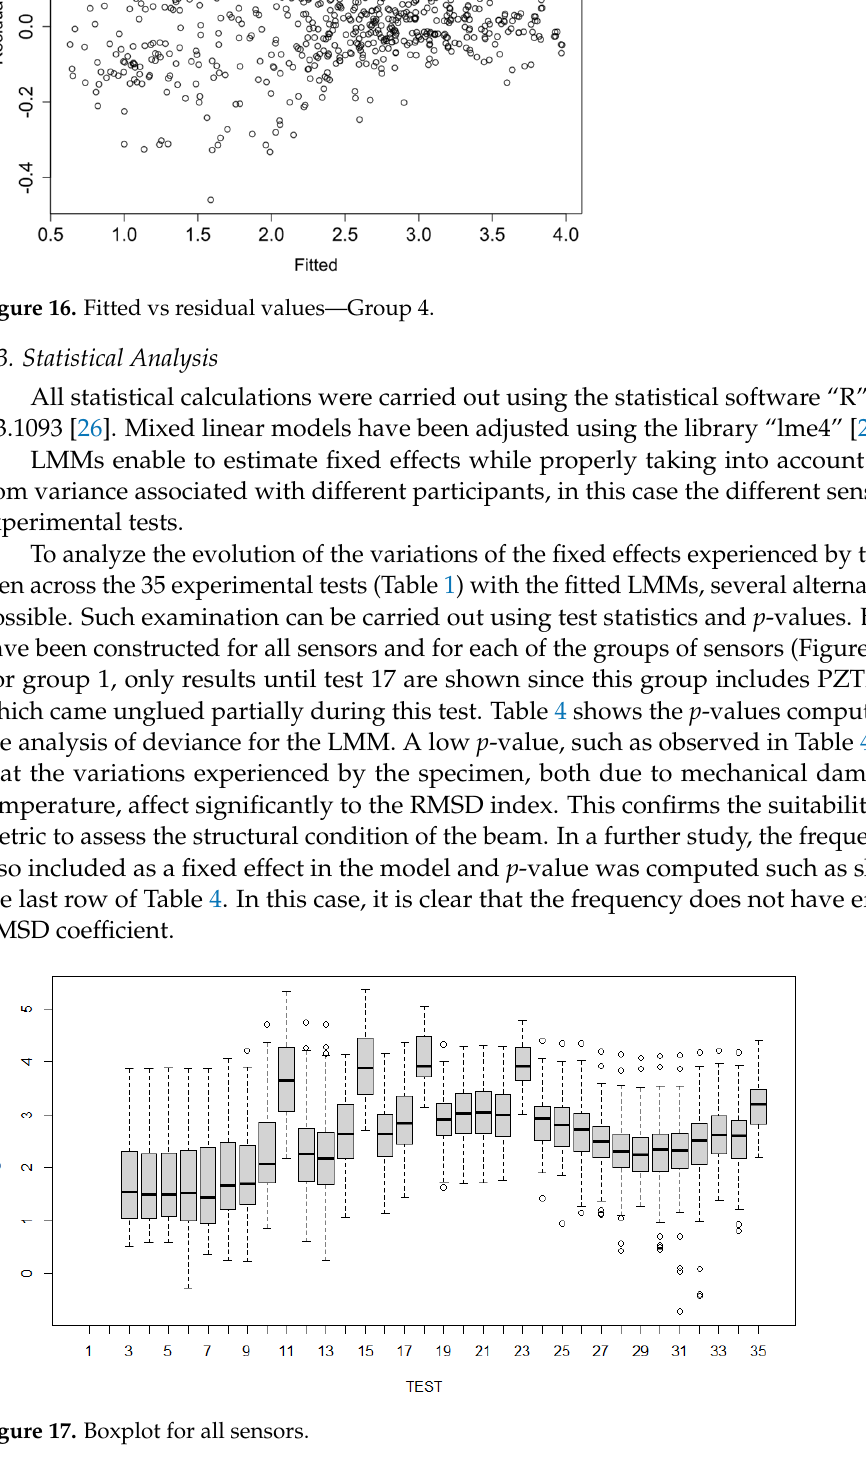
Figure 18. Boxplot for sensors of group 1. Figure 19. Boxplot for sensors of group 2.